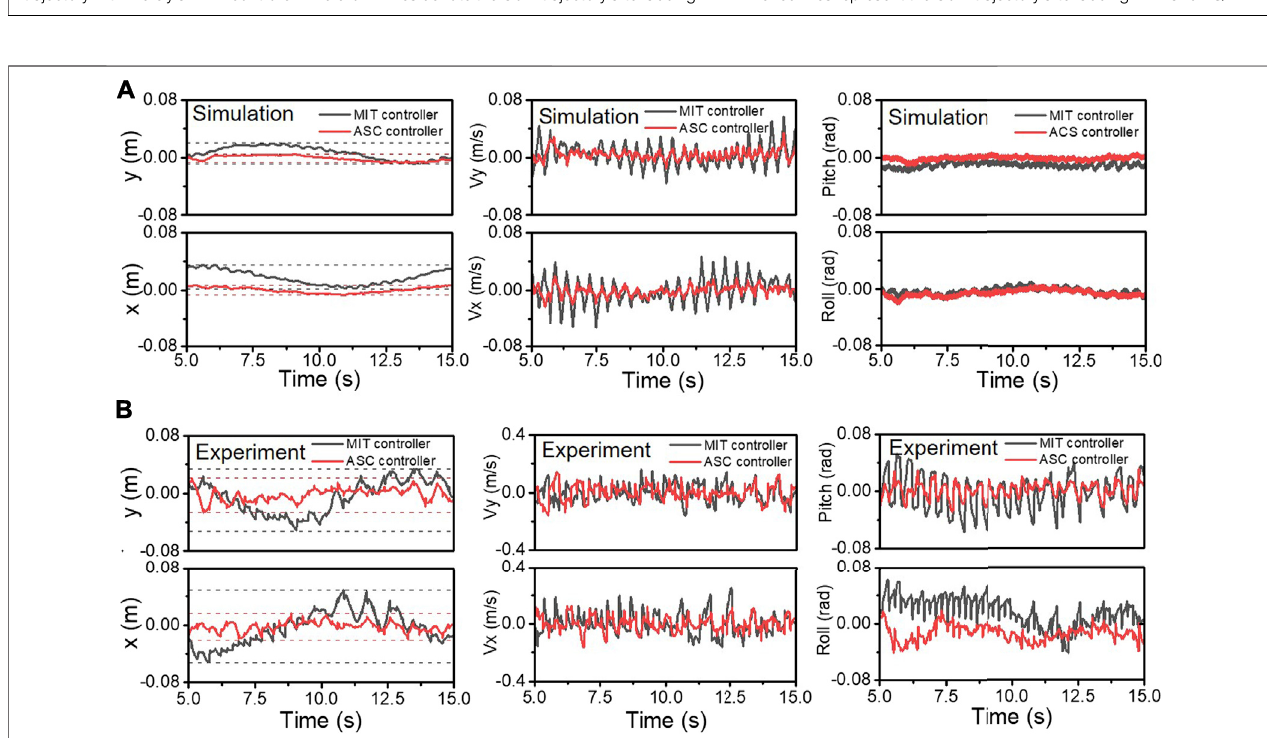
FIGURE 7 | The CoM position, velocity, and attitude of body during spinning in simulation (A) and experiments (B) are recorded. The black and red lines represent the results of the MIT controller and our ASC controller, respectively.